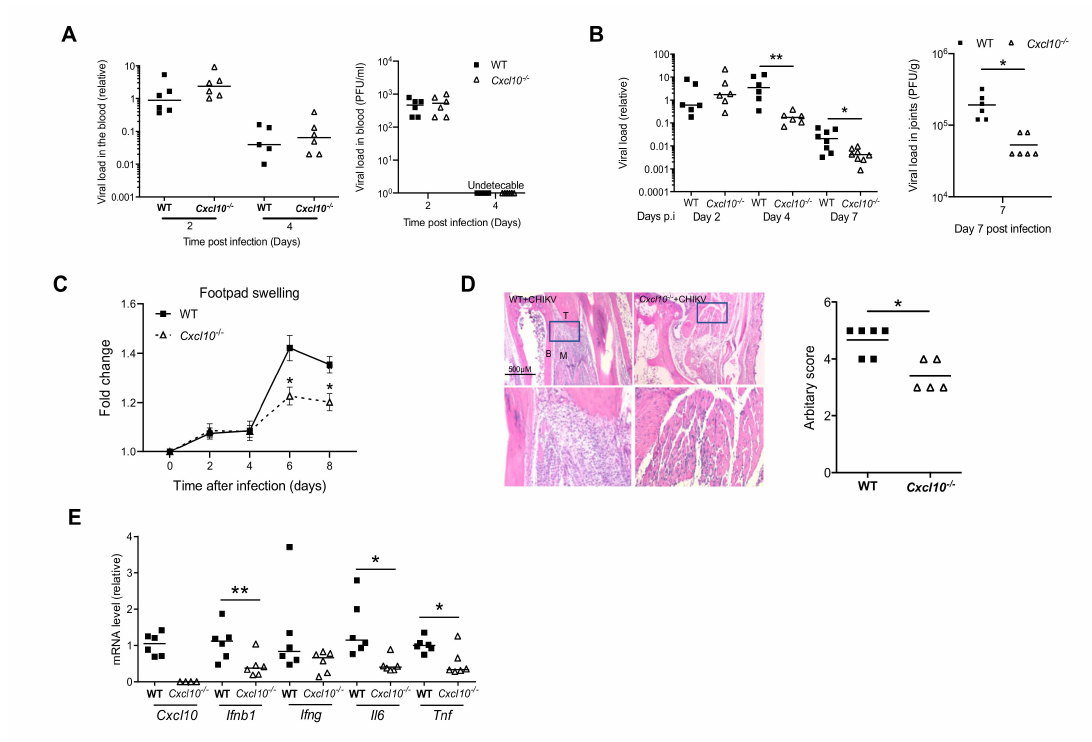
Figure 1. CXCL10 signaling facilitates Chikungunya virus (CHIKV) pathogenesis in mouse feet. Age- and sex-matched C57BL / 6 (wild-type (WT)) and Cxcl10 -deficient ( Cxcl10 − / − ) mice were infected with CHIKV. ( A ) Quantification of viremia by qPCR in whole blood cells (left panel) and a plaque assay (PFU / mL serum) (right panel) of WT and Cxcl10 − / − mice. ( B ) Quantification of viral loads by qPCR (left panel) and a plaque forming assay (PFU / g tissue, day 7) at various days after infection. ( C ) Fold changes in the footpad dimensions of CHIKV-infected mice (Days 2, 4, 6, and 8) in comparison to the uninfected mice (Day 0) ( n = 8 per genotype). Error bar: mean ± s.e.m. *, p < 0.05, non-parametric Mann–Whitney test. ( D ) Representative hematoxylin and eosin staining (H&E) micrographs and arbitrary scores of ankle joint inflammation and damage using a scale of 1 to 5, with 5 representing the worst disease at 7 days after CHIKV infection. N = 5–6 / genotype. Magnifications 40 × . B: bone, T: tendon, and M: muscle. Boxed areas indicate the regions with infiltration and tissue damage. Magnification: 200 × . ( E ) qPCR quantification of cytokines in ankle joints at day 8 post infection (p.i.). Each dot = one mouse. The horizontal line in each column = the median. * p < 0.05; ** p < 0.01 ((non-parametric Mann–Whitney test for ( B , D ) and two-tailed Student’s t -test for ( E